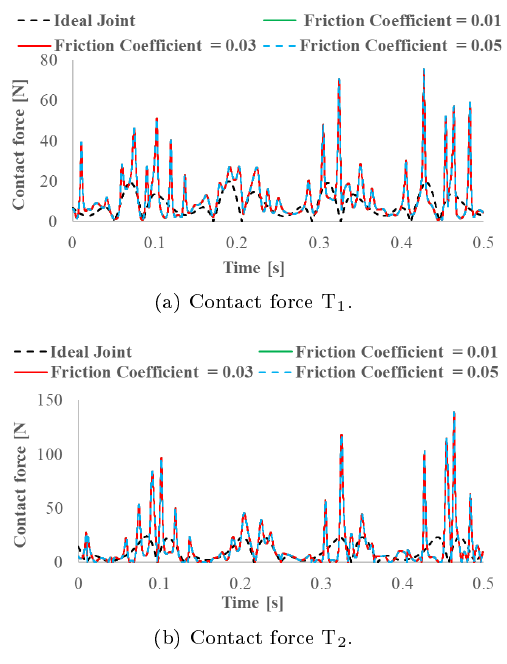
Fig. 15: Contact force at di(cid:27)erent friction